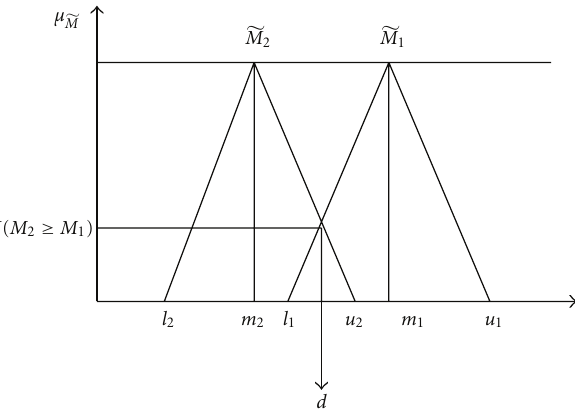
Figure 1: Comparing M 1 and M 2